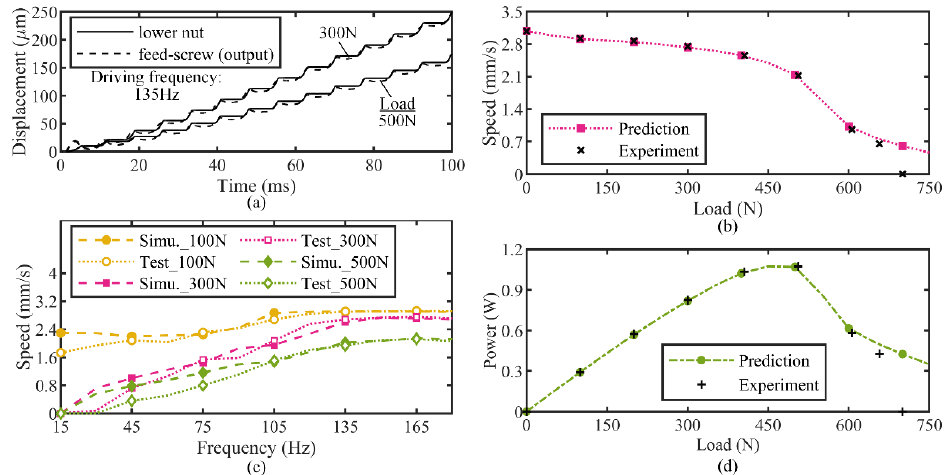
Figure 10. The output performance of the actuator. ( a ) Transient displacement of lower nut and feed screw; ( b ) speed versus load curve; ( c ) frequency ‐ dependent characteristic; ( d ) power versus load plot.